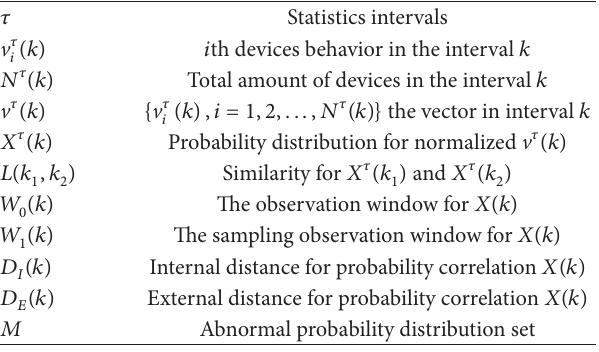
Table 4: Idioms and terms defined in DoS attack cases.